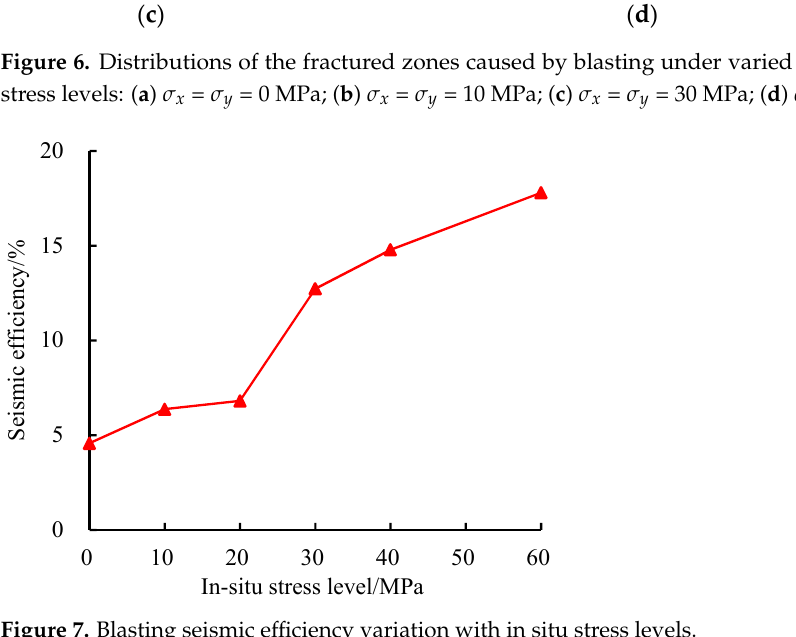
Figure 7. Blasting seismic efficiency variation with in situ stress levels.